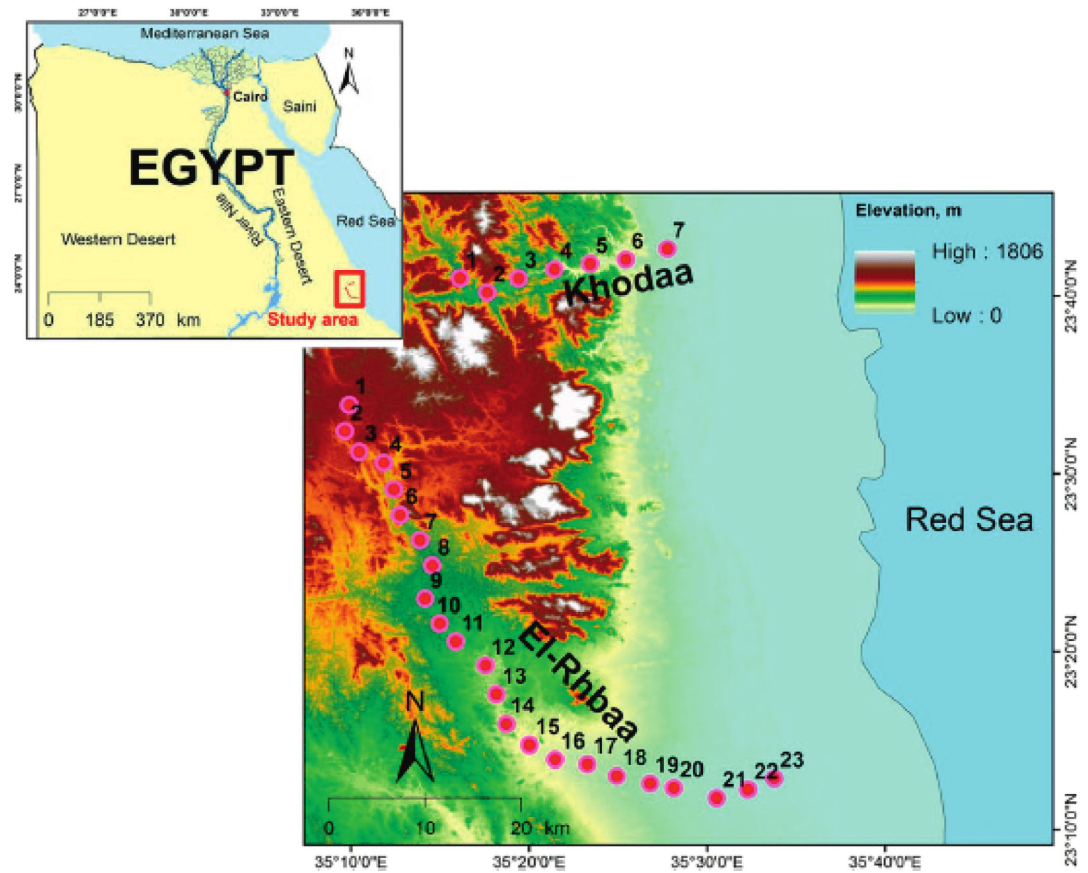
Figure 1: Site map of the collected gypsum samples (Gabal Elbah) [15].